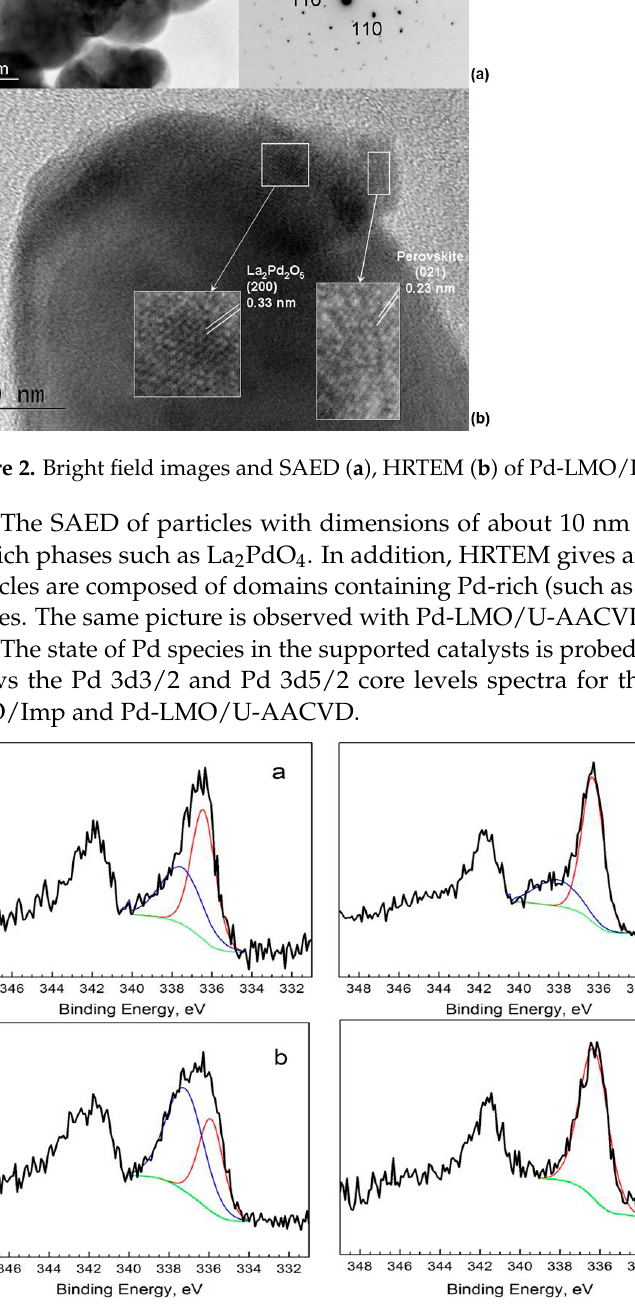
Figure 3. XPS spectra in the Pd 3d3/2 and Pd 3d5/2 regions for fresh Pd-LMO/Imp ( a ) and Pd-LMO/U-AACVD ( b ), as well as for catalytic tested Pd-LMO/Imp ( c ) and Pd-LMO/U-AACVD ( d ). The peak deconvolution in the Pd 3d5/2 region is indicated with blue and red lines. The Shirley’s type of background is also shown (green lines).